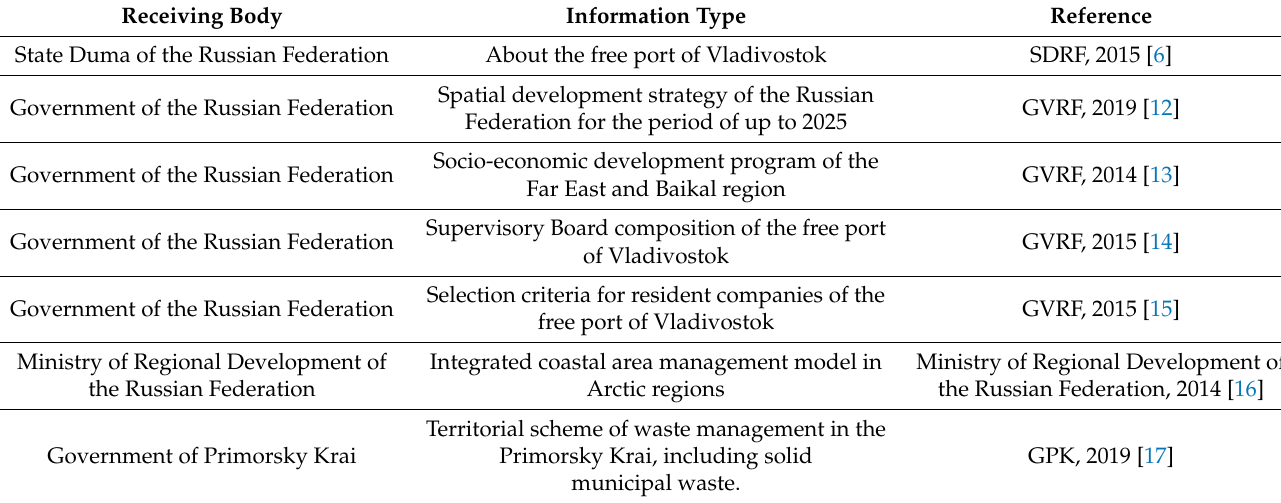
Table 2. The list of analyzed international, national, regional and local